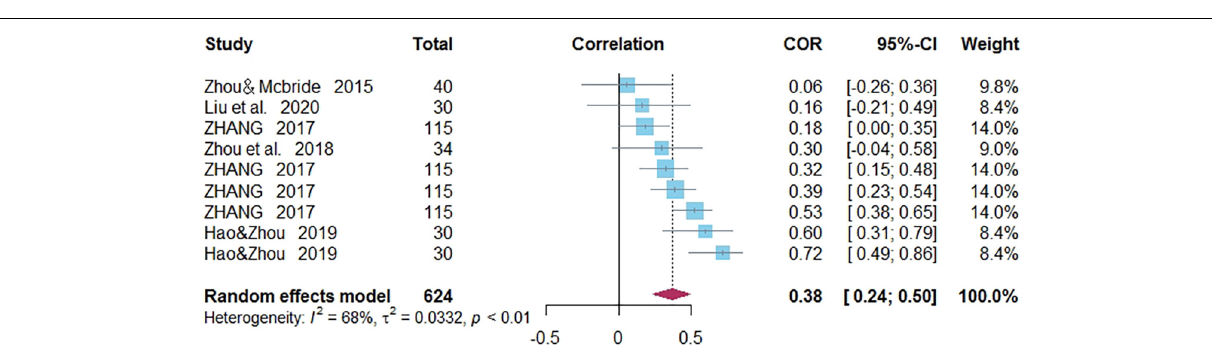
FIGURE 6 | Forest plot of the correlations between orthographic awareness and Chinese word